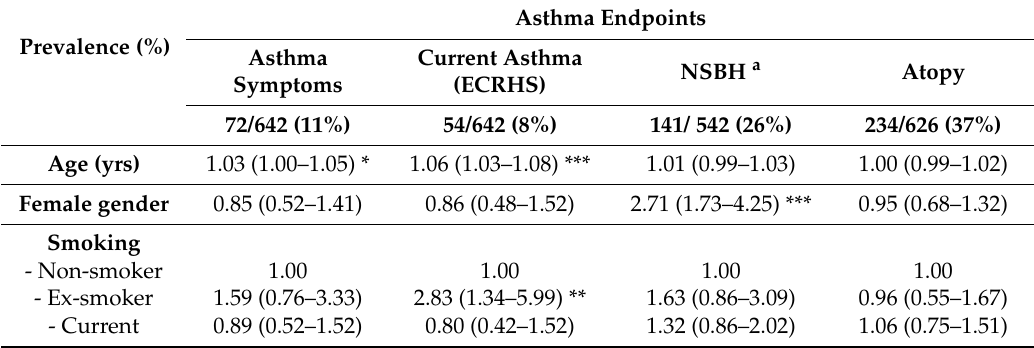
Table 4. Prevalence of asthma endpoints and unadjusted logistic regression models in relation to demographic characteristics among fishing village inhabitants along the West Coast of South Africa.